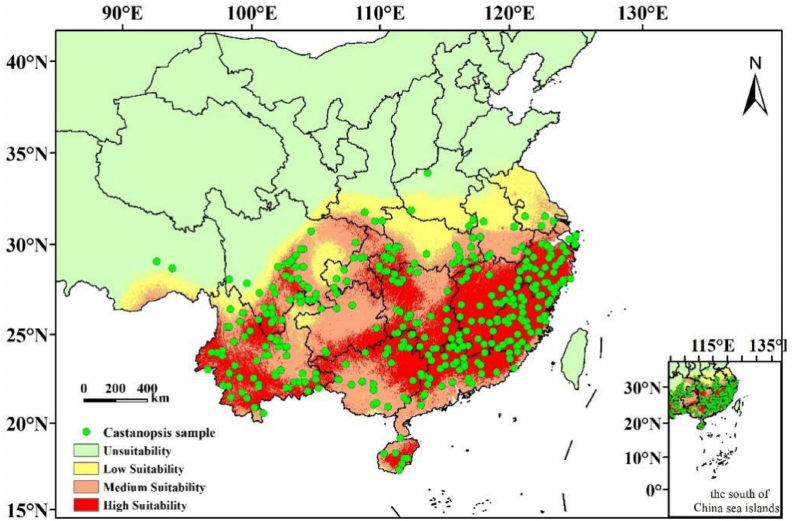
Figure 3. Potentially suitable cultivations regions of C. hystrix Miq. in China under present cli- matic conditions. Table 2. Potential suitable area of C. hystrix Miq. under different climate change scenarios ( × 10 4 km 2 ). Climatic